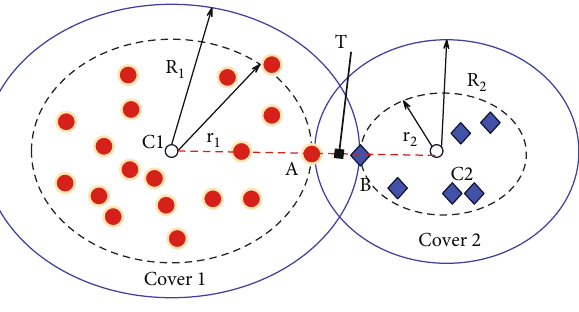
Figure 4: Analysis of membership function.